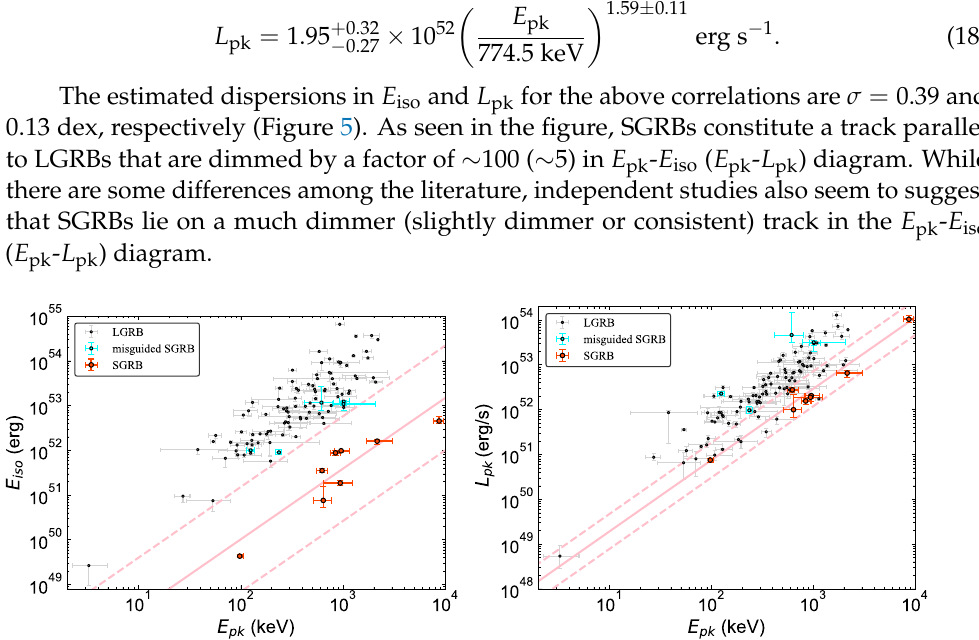
Figure 5. The E pk - E iso ( left ) and E pk - L pk ( right ) diagrams of SGRBs taken from Tsutsui et al. [139]. According to the analysis of Tsutsui et al. [139], red circles represent secure SGRBs, while cyan circles are considered as misguided SGRBs. The best-fitting function and 3 σ intervals of the Amati ( E pk - E iso ) and Yonetoku ( E pk - L pk ) relations for the secure SGRBs are indicated with red solid and dashed lines, respectively. For comparison, observational data of LGRBs taken from Yonetoku et al. [112] are shown by gray points. Data from Tsutsui et al. [139] and Yonetoku et al.